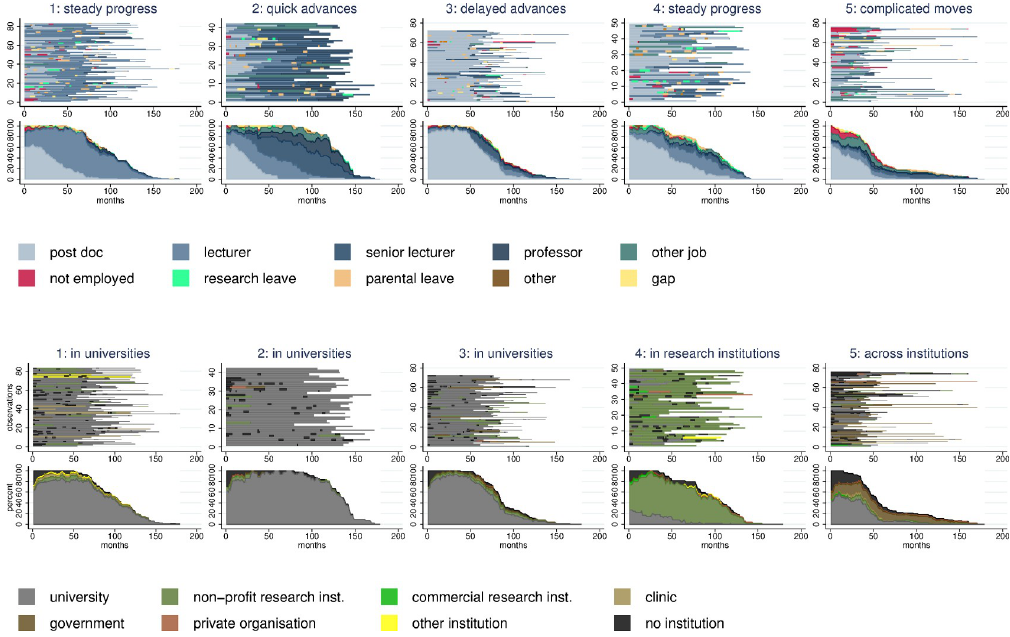
Fig 1. Starting grant career patterns. Sequence index plots and status proportion plots for positions and